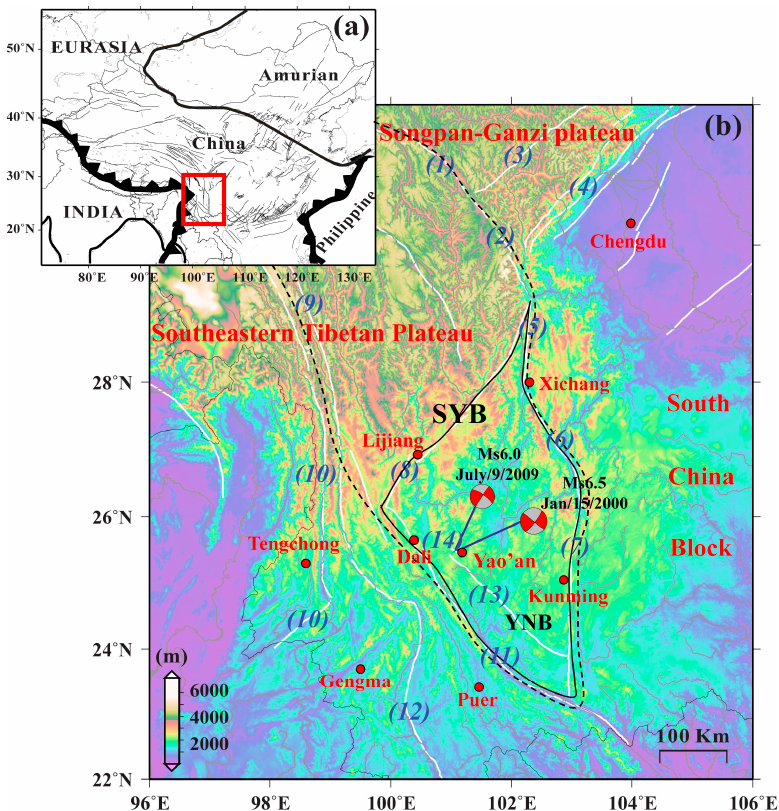
Figure 1. ( a ) Tectonic location of the Yao’an and its surroundings in China, as well as the major plate boundaries in and near mainland China. The red box indicates Yao’an and its adjacent tectonic belts ( b ). The white solid lines represent major active faults [30]. The small red circles represent major cities. The red star indicates Yao’an. The focal mechanism balls represent the 2009 Yao’an Ms6.0 earthquake and 2000 Yao’an Ms6.5 earthquake (GCMT). The characters in italics represent the major faults of the region, such as Ganzi-Yushu (1), Xianshuihe (2), Longriba (3), Longmenshan (4), Anninghe (5), Zemuhe (6), Xiaojinghe (7), Lijiang–Xiaojinhe (8), Jinshajiang (9), Nujiang (10), Red River (11), Lancangjiang (12), Nahua-Chuxiong (13), and Maweijing (14). The block surrounded by the black dotted line is Sichuan-Yunnan block (SYB), which is also called Chuandian Block. The rhombic block enclosed by the black thin solid line is the Yunnan block (YNB), which is also called Diandong Block.